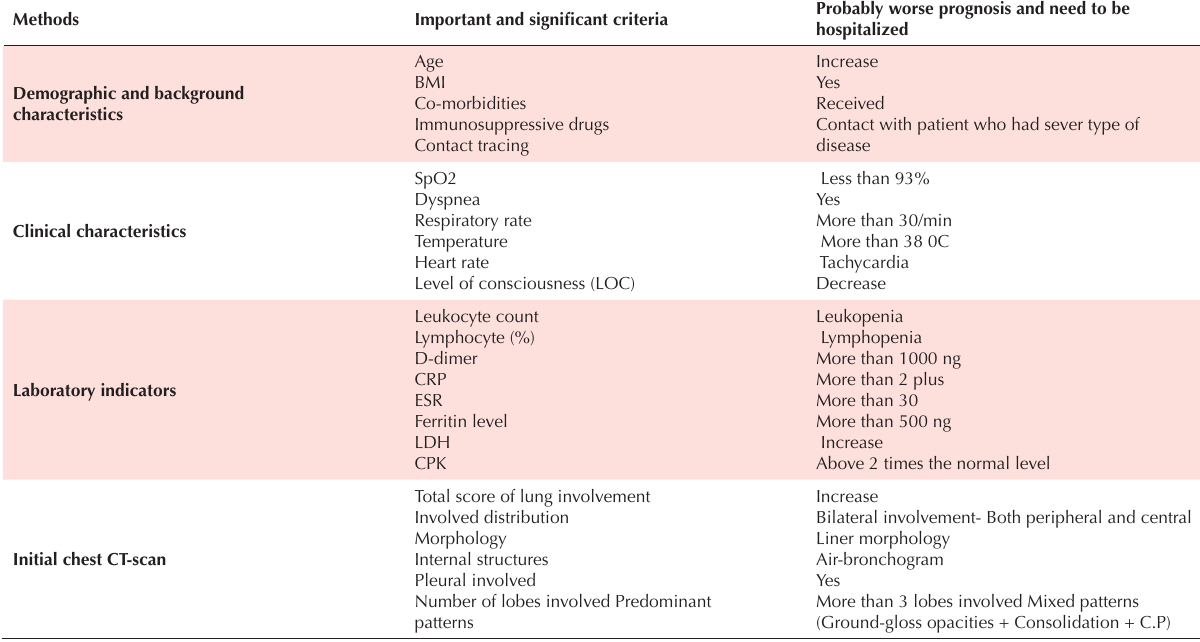
Figure 2. Flowchart of Triage methods to decide home-discharge versus hospitalization in COVID-19 patients. Abbreviations: body mass index (BMI), LOC (level of consciousness), CRP (C-reactive protein), ESR (Erythrocyte sedimentation rate), Ferritin level, LDH (Lactate dehydrogenase), CPK (Creatine Phosphokinase). Table 1. Details of important criteria in each method to guide clinicians